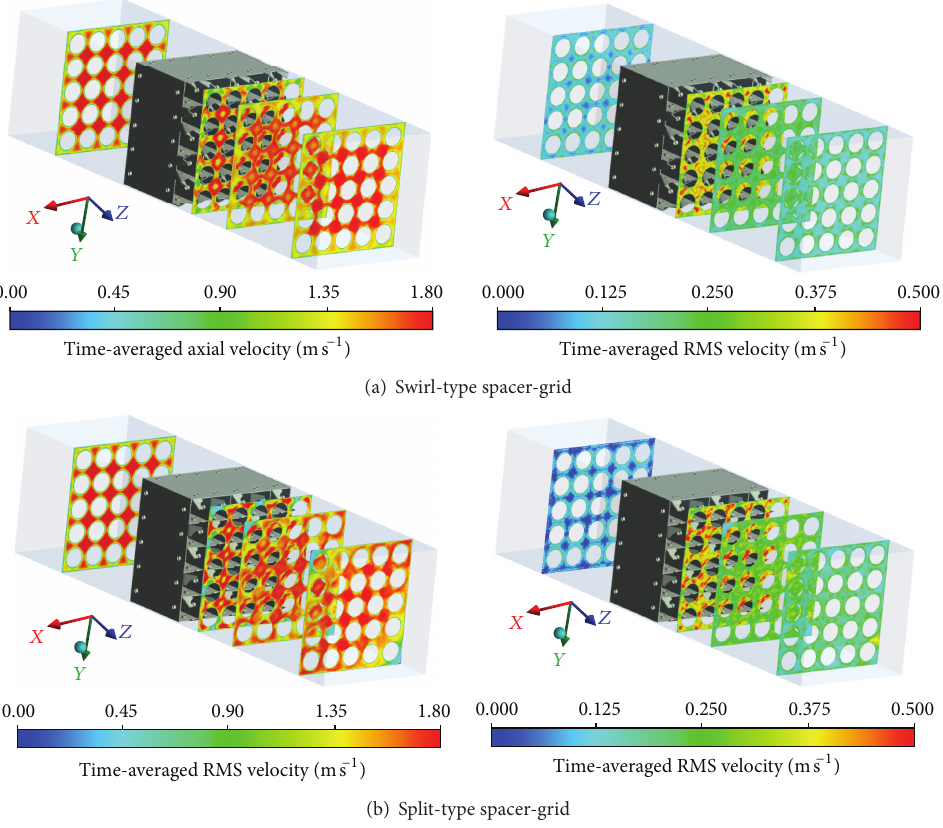
Figure 19: Time-averaged velocity, RMS fluctuating velocity at 1 𝐷 𝐻 , 4 𝐷 𝐻 , and 10 𝐷 𝐻 downstream of the spacer-grid.